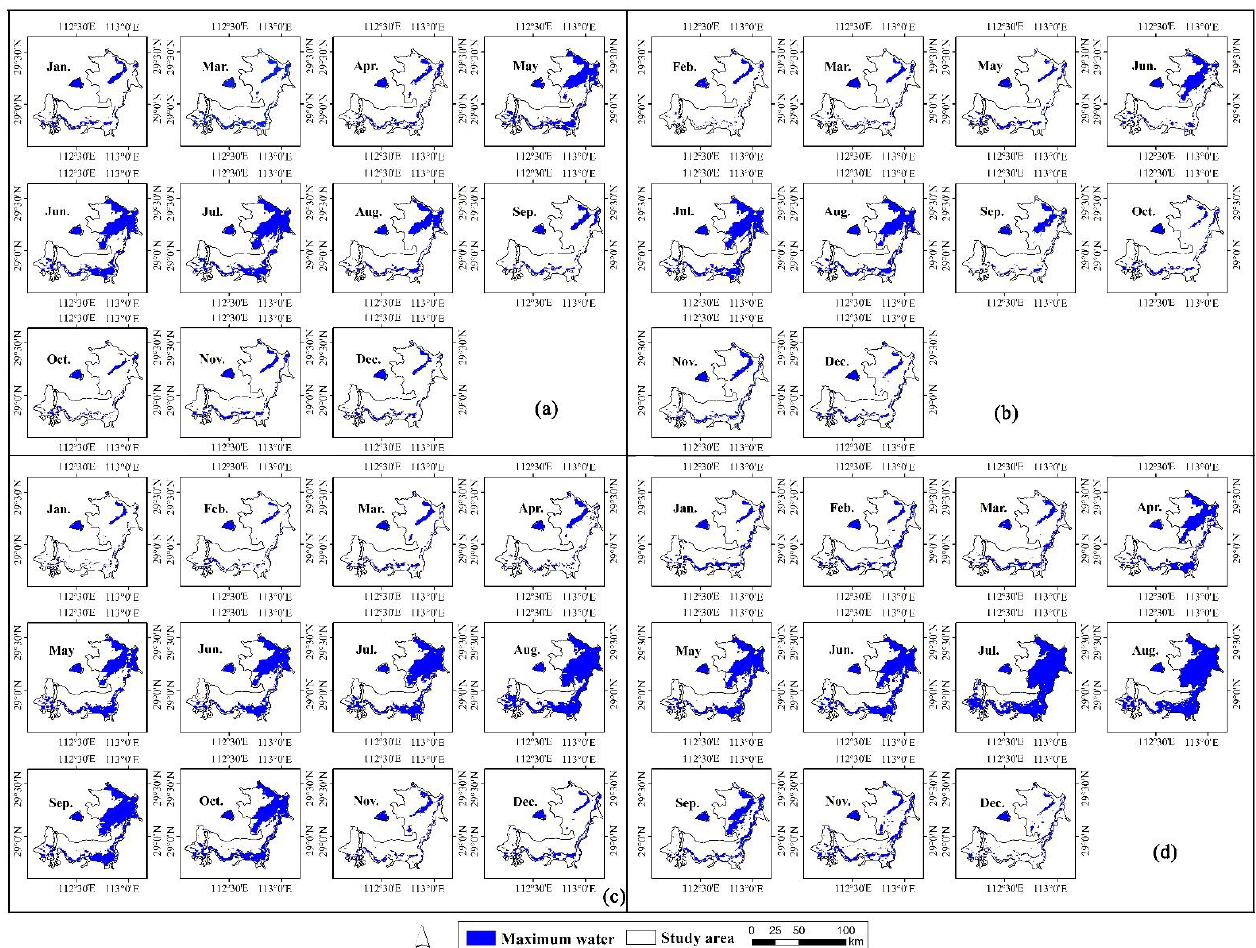
Figure 10. Dongting Lake monthly surface water in ( a ) 2006, ( b ) 2011, ( c ) 2010 and ( d ) 2016.